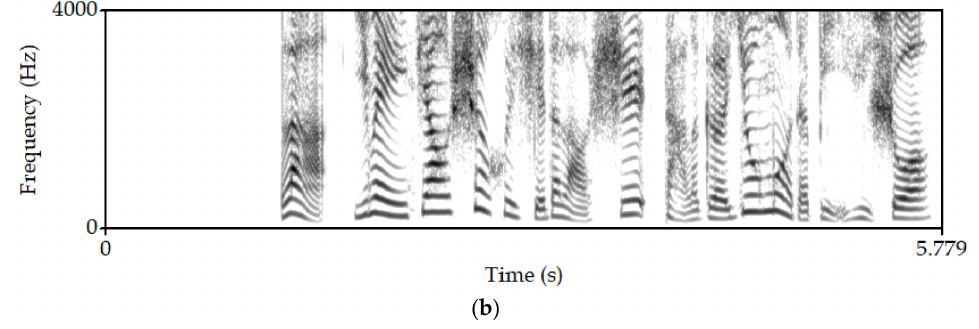
Figure 6. Damaged speech signal, the tampering percentage is 19.5% ( a ) Waveform ( b ) Spectrogram.